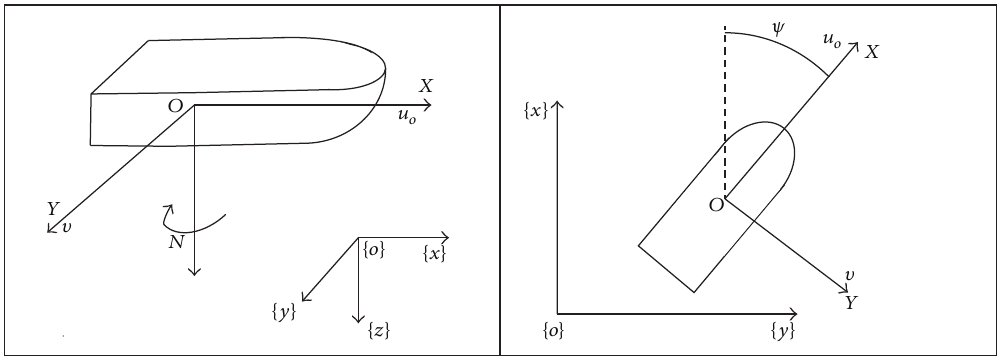
Figure 1: Body (O) and earth-fixed ( {𝑜} ) reference frames, forces ( 𝑋 , 𝑌 ), moment ( 𝑁 ), and linear speeds ( 𝑢 0 , 𝜐 ) used in marine systems for 3 degrees of freedom (3DOF)